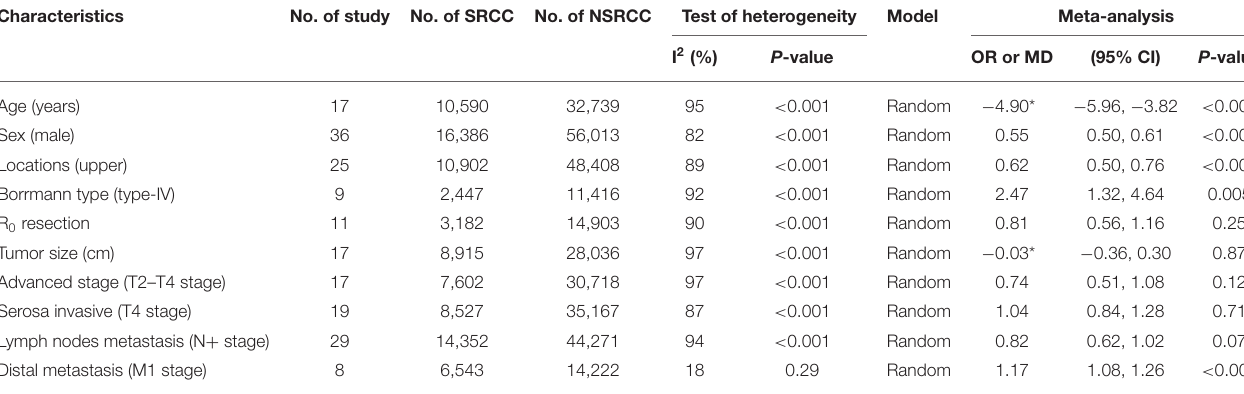
TABLE 2 | The meta-analysis of clinicopathological characteristics between SRCC and NSRCC patients. Characteristics